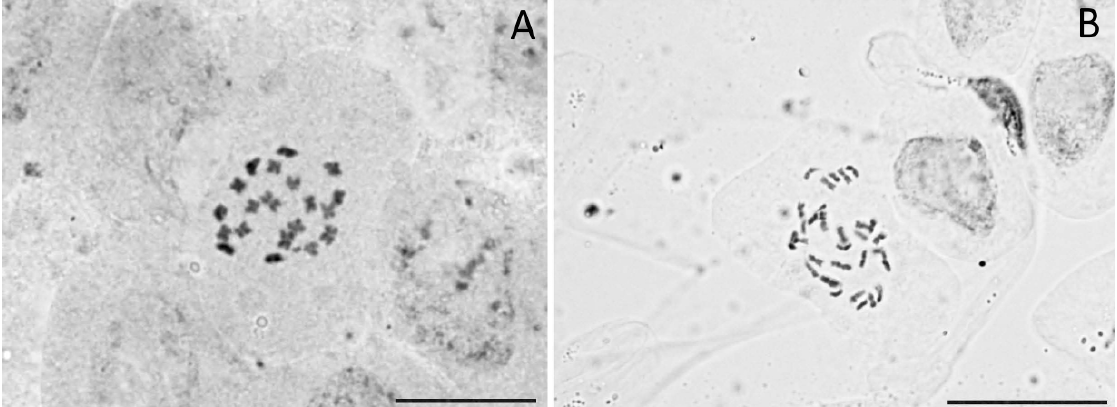
Figure 3. Somatic metaphase plates of a diploid Cannabis individual from the accession IND4— North India (2n = 20) ( A ) and a triploid individual from the accession IND1—North India (2n = 30) ( B ). Scale bars = 10 µm.